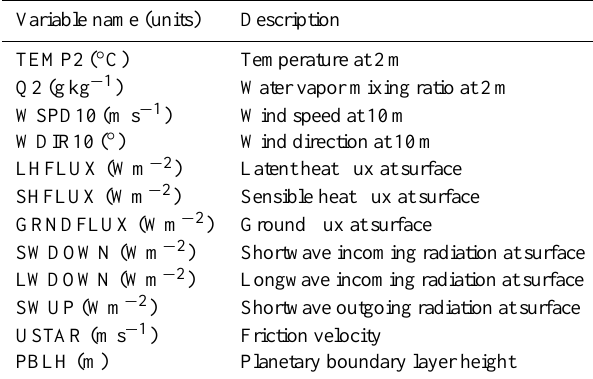
Table 1. Variable names and descriptions for the